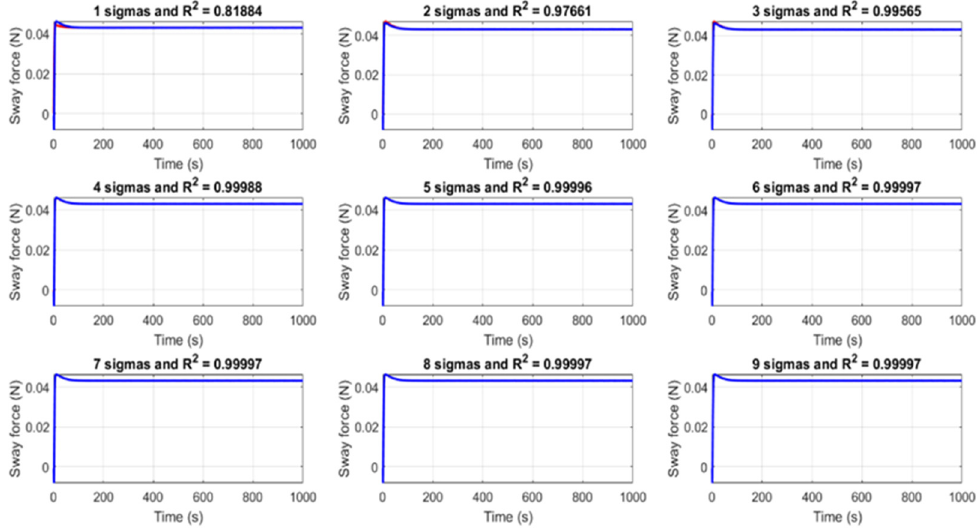
Figure 4. Measured (blue curves) vs. estimated sway forces (red curves) for 25° turning manoeuvre.